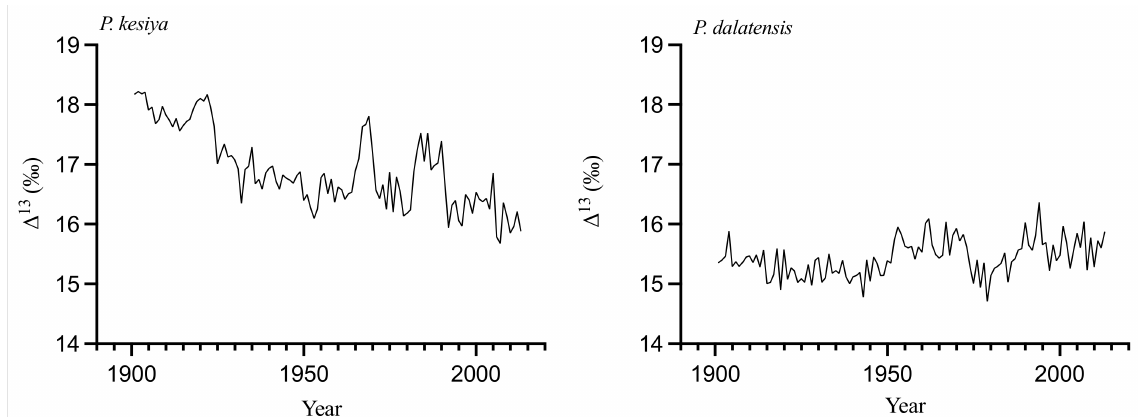
Figure 5. Chronologies of 13 C discrimination against atmospheric CO 2 ( ∆ 13 C) of P. kesiya ( n = 3) and P. dalatensis ( n = 5) from 1901 to